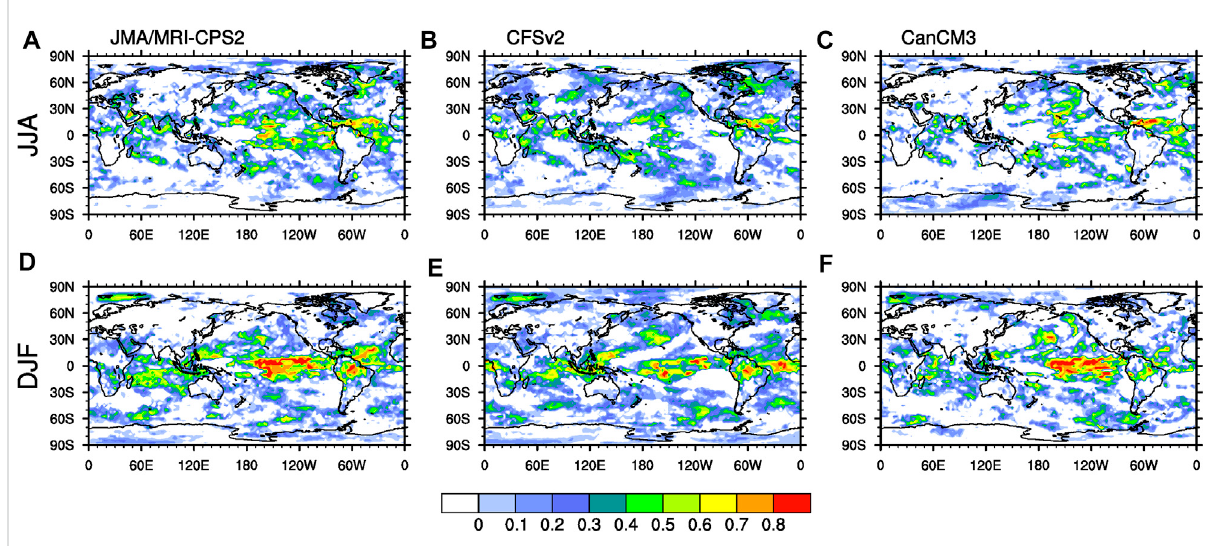
FIGURE 5 Spatial distributions of Brier Skill Scores (BSS) for the above normal (AN) event for JMA/MRI-CPS2 (A,D) , CFSv2 (B,E) and CanCM3 (C,F) of temperature in JJA (A – C) and DJF (D – F) season for the period 1982 – 2011.